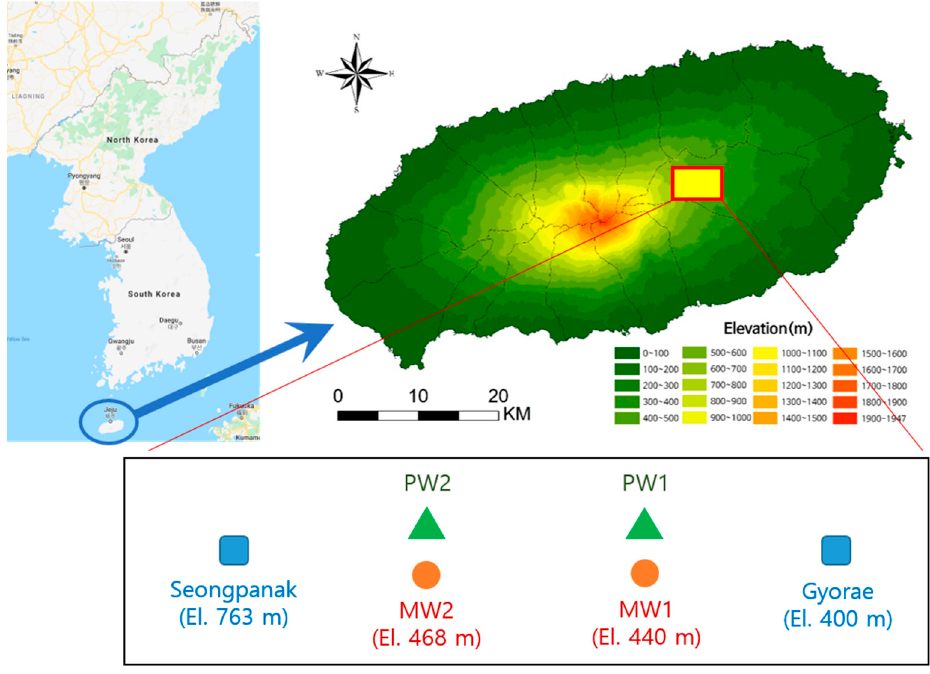
Figure 1. Schematic of the positions of rainfall stations, groundwater pumping wells, and groundwater monitoring wells. Table 1. Data period of rainfall stations, groundwater pumping wells, and groundwater monitoring wells.